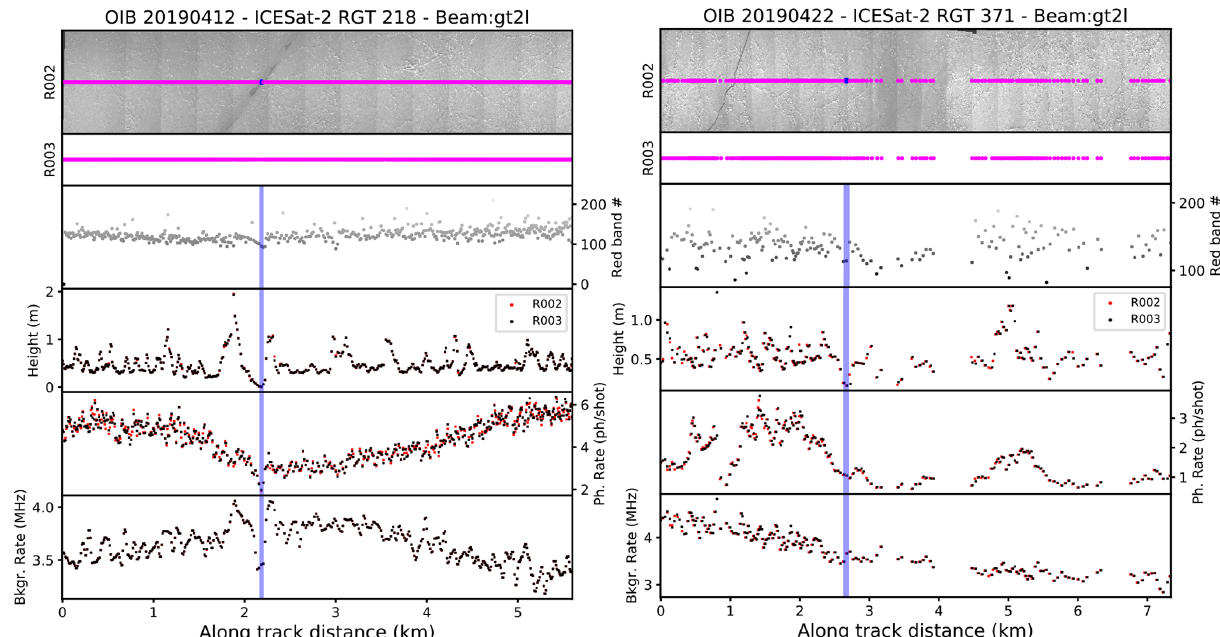
Figure 2. Effect of clouds on IS-2 photon rates, background rates and surface-type classification in IS-2 in R002 and R003 on (left) 12 April 2019 (RGT-218) and (right) 22 April (RGT-371). Top: ATL10 overlaid on CAMBOT RGB imagery, with magenta markers in- dicating sea ice segments and blue indicating sea surface (smooth dark lead) in R002 ATL10; second panel: magenta markers indicating sea ice segments in R003 (there are no lead segments); third panel: red band intensity in the CAMBOT RGB image at the location of the ATL10 segments; fourth panel: ATL10 surface height; fifth panel: ATL10 photon rate; sixth panel: ATL10 background rate. In panels 4–6, red represents R002 and black represents R003. The vertical blue shading shows the location of the ATL10 sea surface reference (smooth dark lead) segment in R002. Low contrast in the CAMBOT imagery is due to low solar elevations of 8 and 11 ◦ during